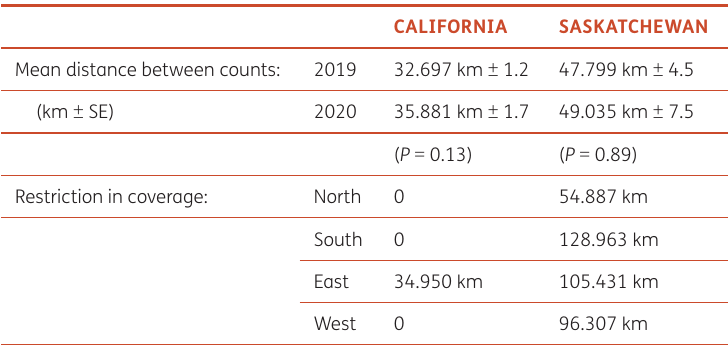
Table 2 Differences in spatial distribution of CBC counts in 2019 and 2020 for California and Saskatchewan, two regions exhibiting the greatest reduction in counts owing to the pandemic. Mean distance between counts was produced by proximity analysis in ArcMap. Restriction in coverage is the difference in spatial limit in 2019 compared with 2020 in each of the cardinal directions.